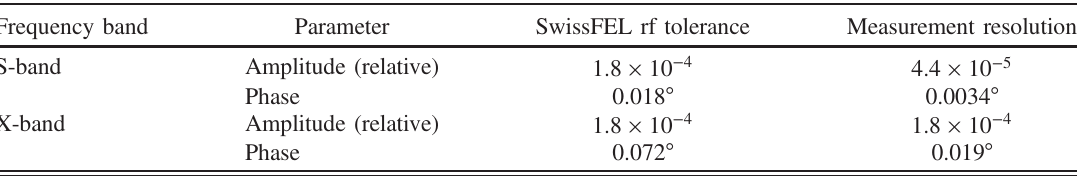
TABLE IX. Pulse-to-pulse jitter resolutions of the llrf measurement system for the two frequency bands, compared to SwissFEL tolerances (rms values). The averaging window size for the jitter measurements is 900 ns (100 ns) for S-band (X-band).